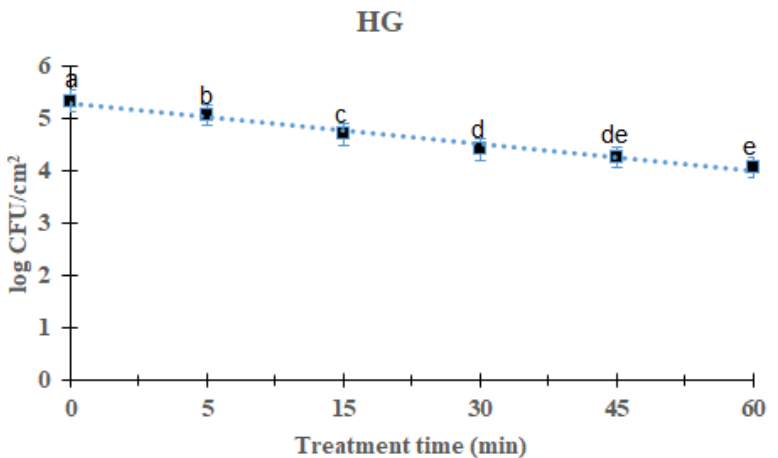
Figure 2. Survival curves of Listeria monocytogenes biofilm in a latex hand glove treated by DBD plasma using the first-order kinetic model. The data were represented by the mean ± standard deviation of the three independent replicates. a–e Values marked with different letters within each treatment are significantly different according to Duncan’s multiple range test ( p < 0.05).